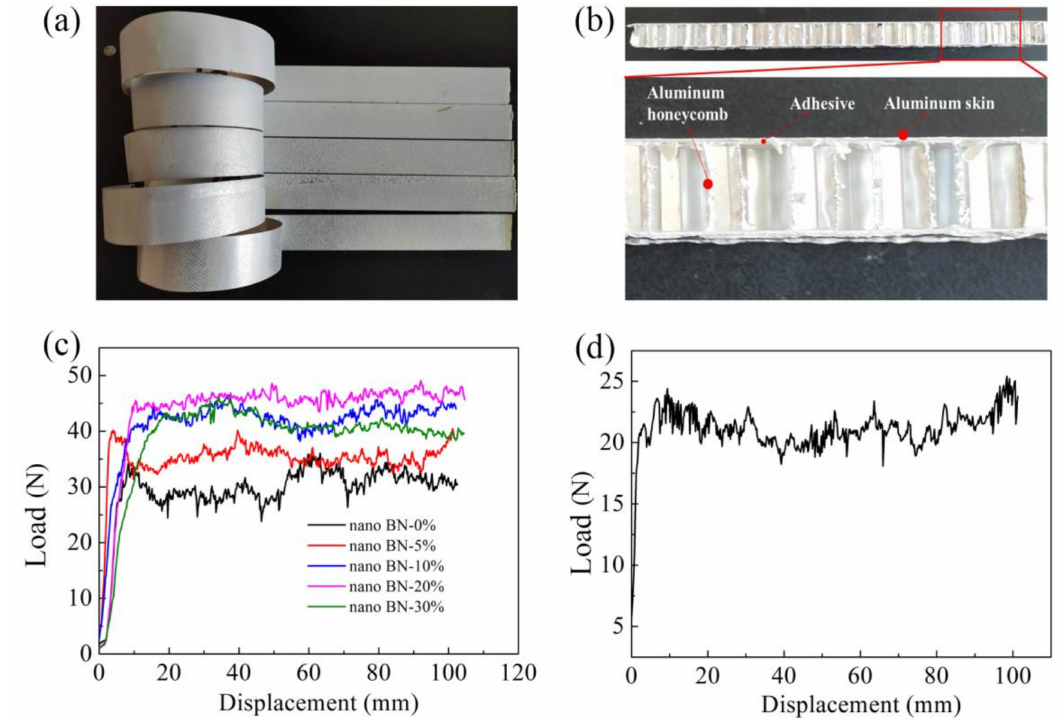
Figure 7. Peel performance of adhesive system: ( a ) metal-to-metal peel samples, ( b ) honeycomb sandwich